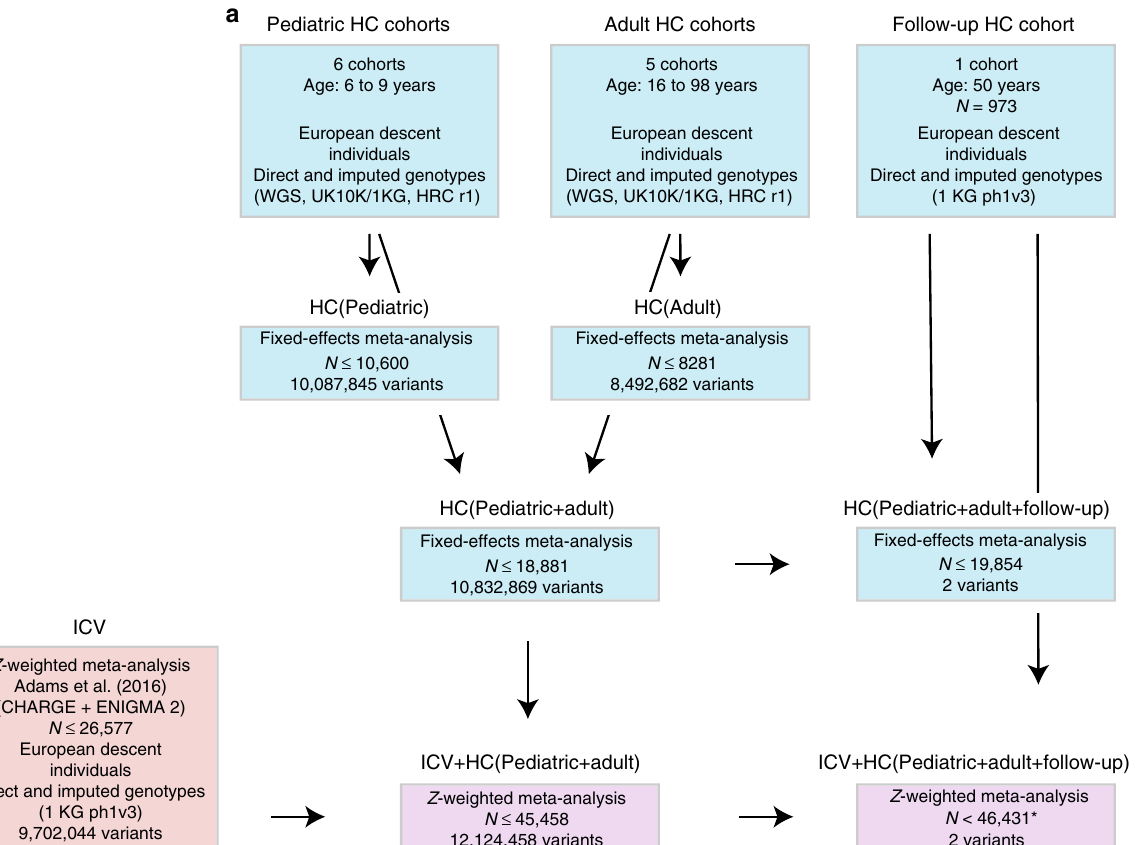
Fig. 1 Study design. a Head circumference meta-analysis design using a fi xed-effect meta-analysis including different developmental stages. b Combined head circumference and intracranial volume meta-analysis design using a Z -weighted meta-analysis. ICV intracranial volume. WGS whole-genome sequencing; UK10K/1KG Joint UK10K/1000 Genomes imputation template, 1KG 1000 Genomes imputation template, HRC The Haplotype Reference Consortium r1. *Due to sample dropout only N ≤ 43,529 were